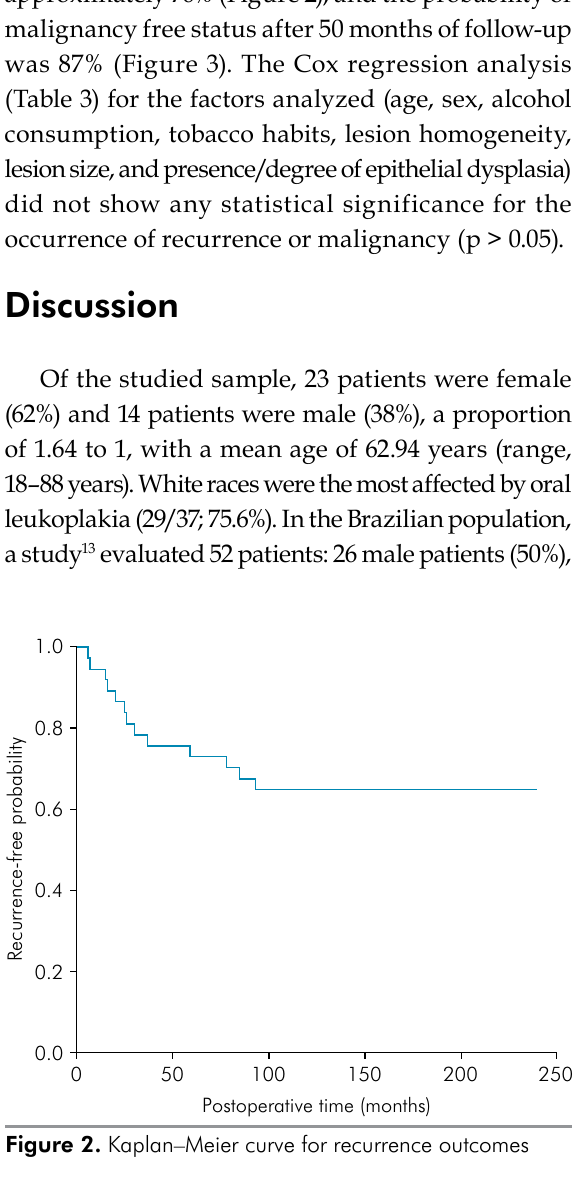
Table 3. Cox regression analysis for the occurrence of clinical outcomes (recurrence and malignancy).